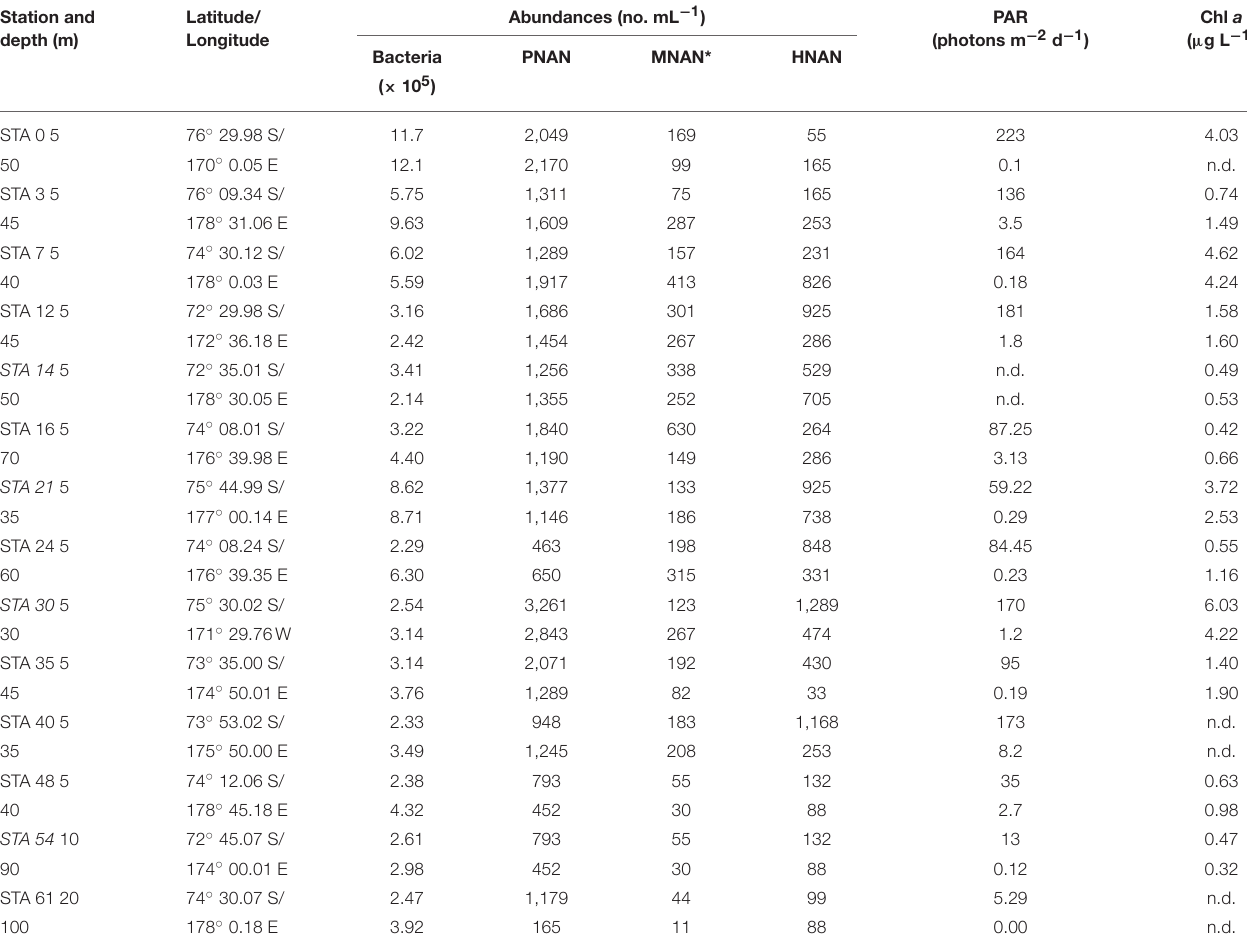
TABLE 1 | Station location, bacterial, and nanoplankton abundances, photosynthetically active radiation (PAR) and chlorophyll a concentrations for NBP-1101 austral summer cruise. Station and depth